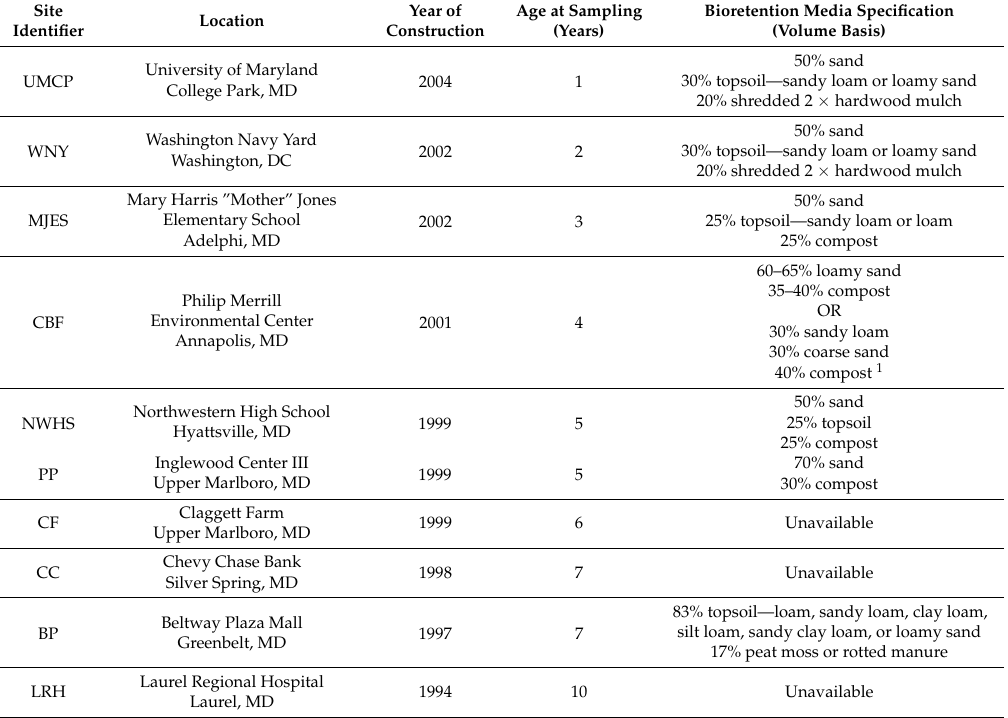
Table 1. Field sites. Bioretention media specification represents the specification as included in construction documents, where